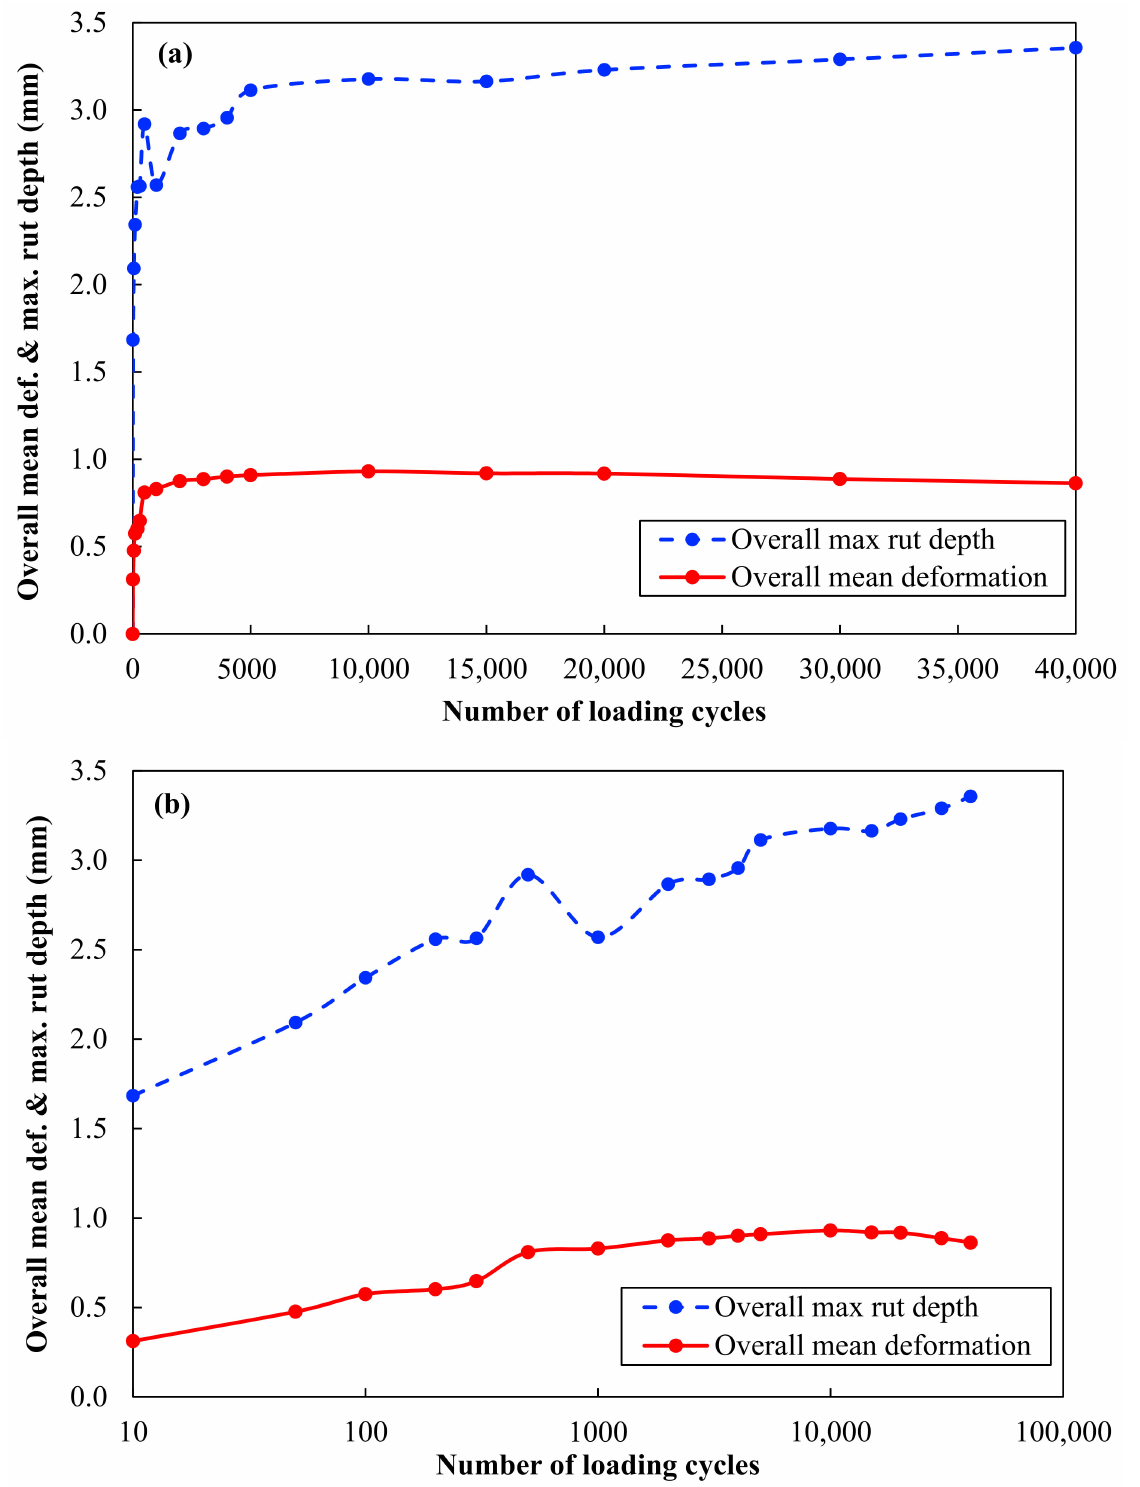
Figure 7. Overall mean surface deformation data and maximum rut depth data for 15% RG + 20% CB + 65% CC: ( a ) Decimal scale and ( b ) semi-logarithmic